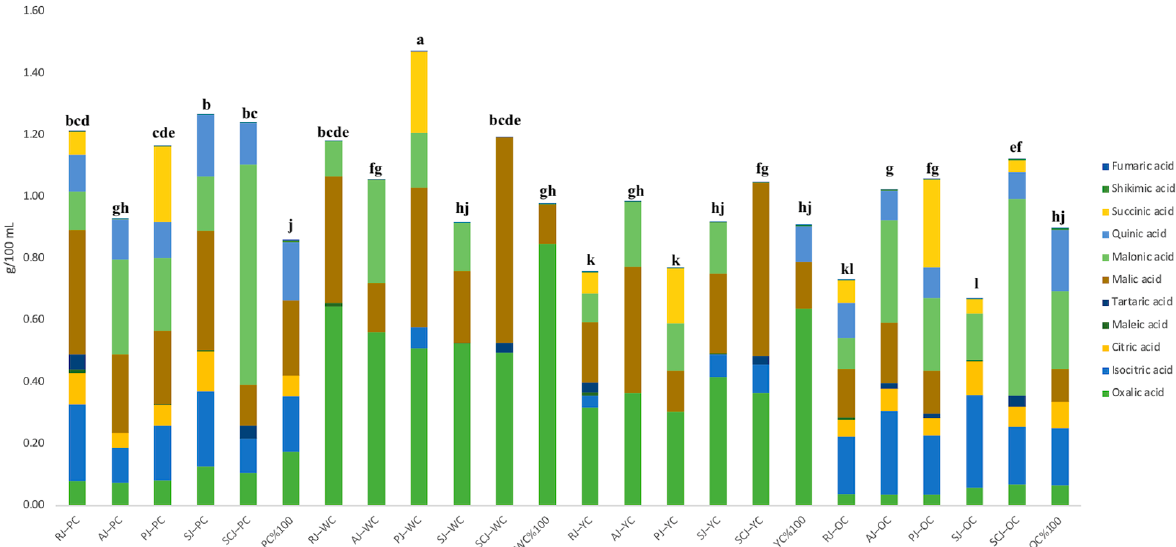
Figure 3. The organic acids (g/100 mL) in carrot-blended smoothies, letters above columns indicate statistical significance at p ≤ 0.05 according to Tukey’s test (the same letter = not significantly different). Total organic acid content: RJ–PC, 1.21bcd. AJ–PC, 0.93gh. PJ–PC, 1.17cde. SJ–PC, 1.27b.